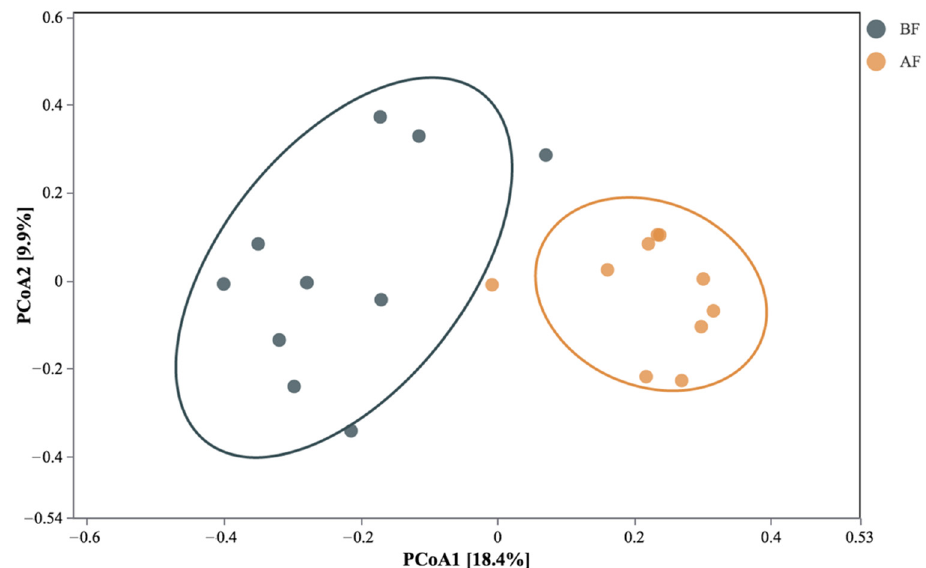
Figure 4. Comparison of eukaryotic communities before and after the flood using principal coordi- nates analysis (PCoA) (BF represents samples collected before floods and AF represents samples collected after floods).